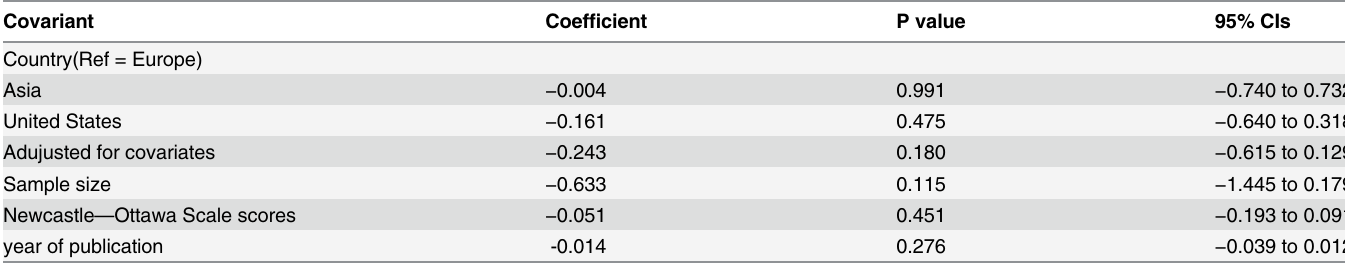
Table 5. Effects of study variables by